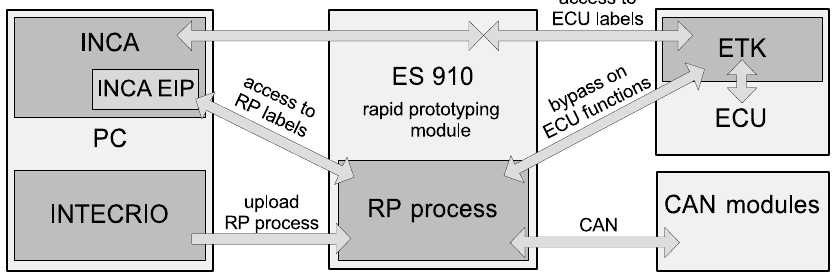
Figure 7. Hardware, software, and interfaces of the testbench setup. EIP: experimental target integration